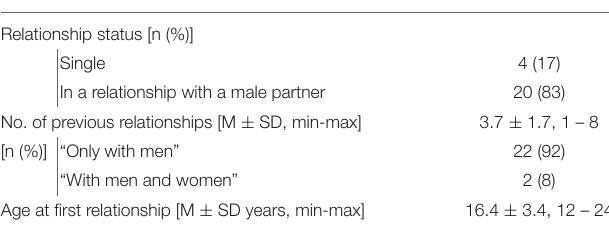
TABLE 1 | Sample characteristics clinical sample ( n =